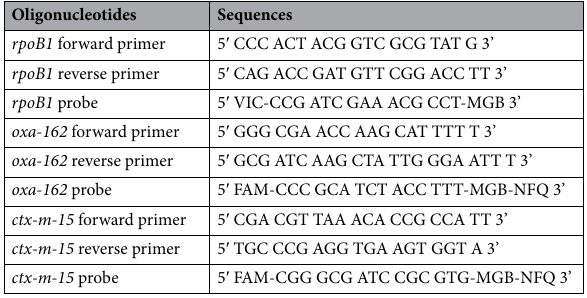
Table 2. Oligonucleotide probes and primers used in qPCR